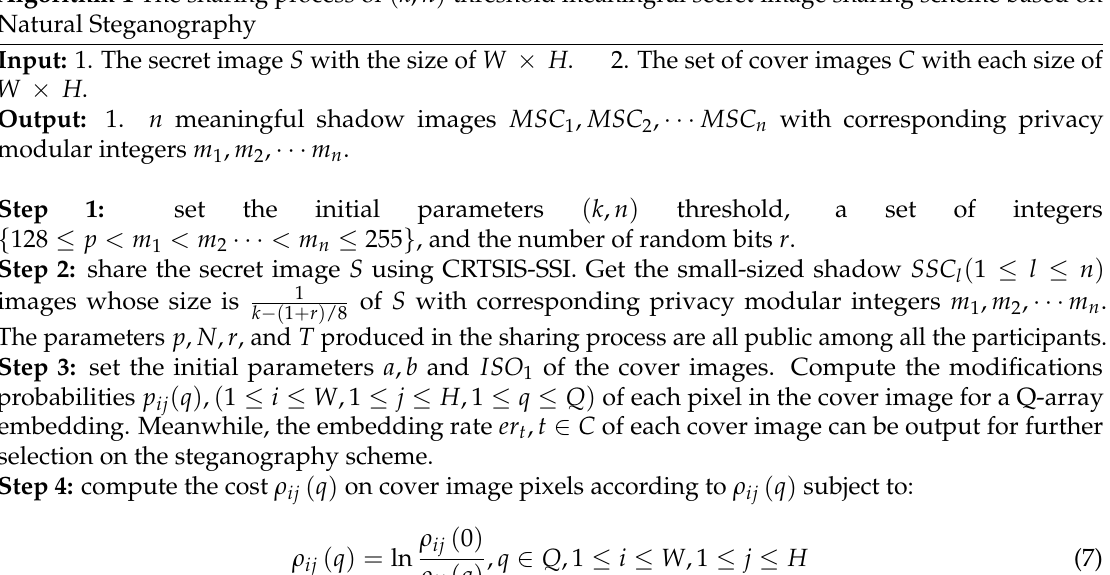
Algorithm 1 The sharing process of ( k , n ) threshold meaningful secret image sharing scheme based on Natural Steganography